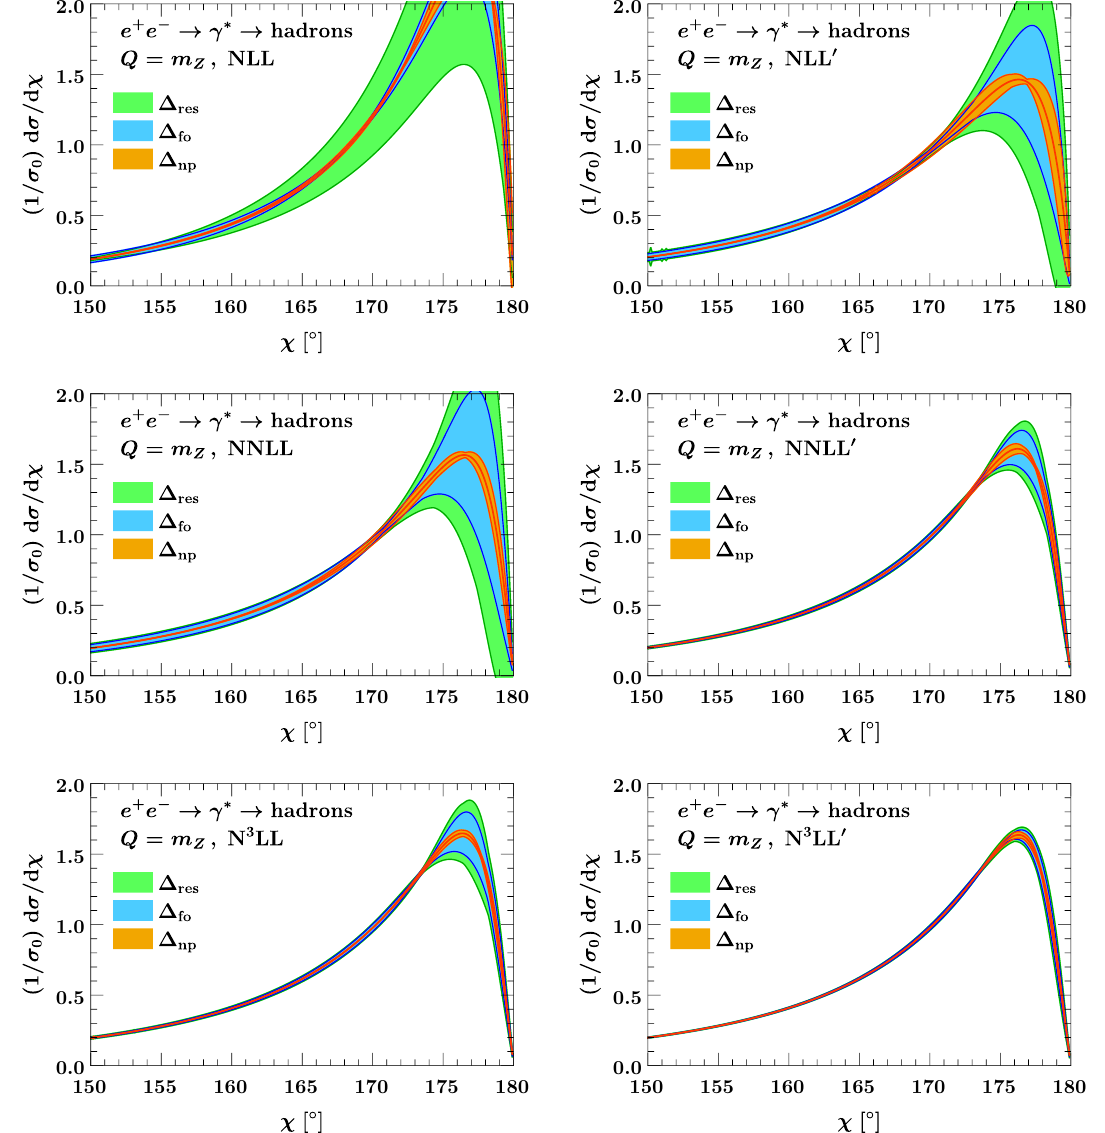
Figure 1 . Breakdown of the total uncertainty into fixed-order ( ∆ fo , blue), resummation ( ∆ res , green) and nonperturbative ( ∆ np ) uncertainties for different resummation